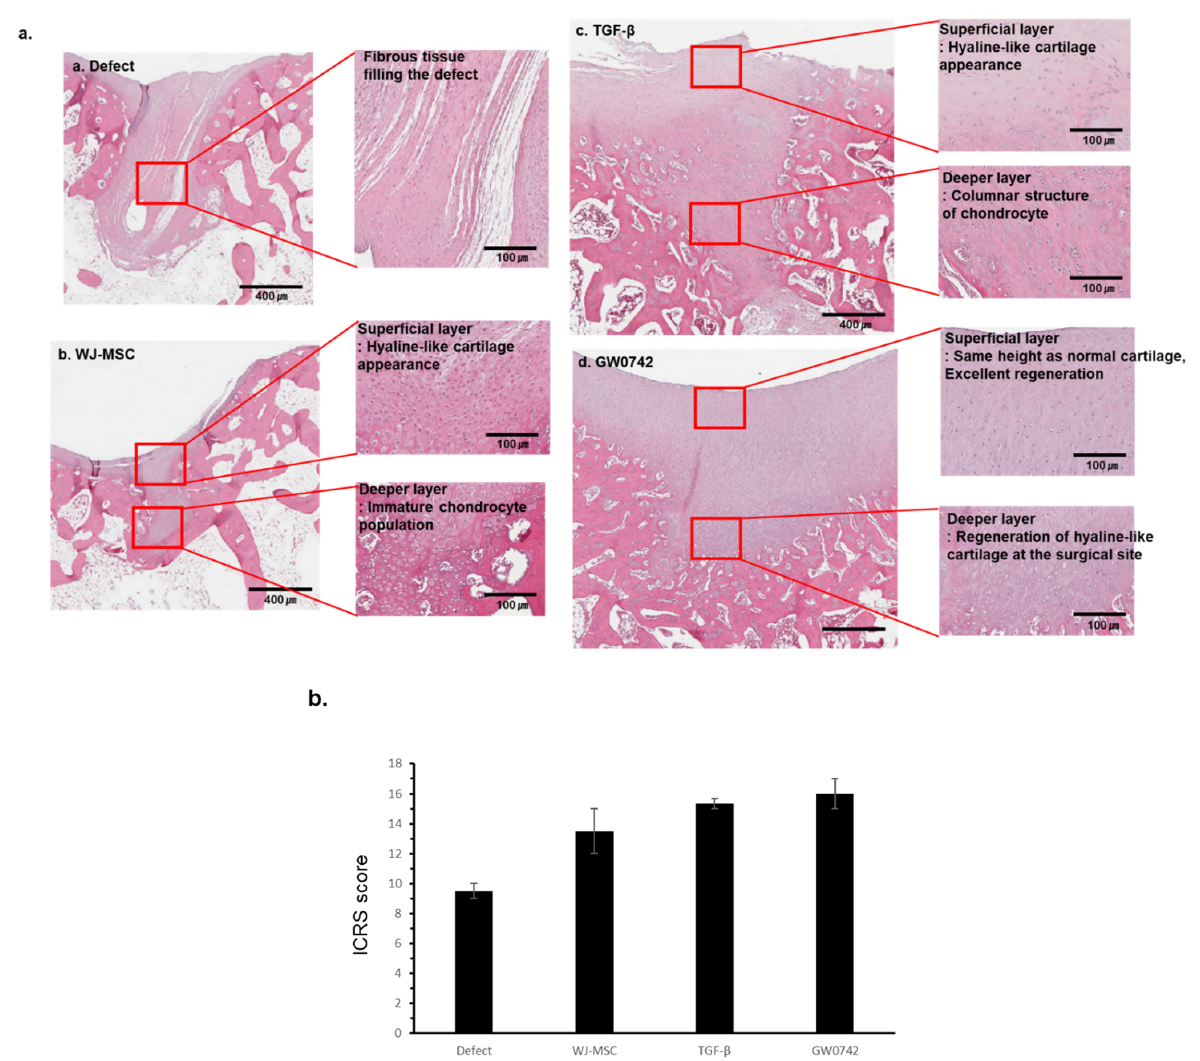
Figure 4. Histological analysis of repaired cartilage by bio-printed scaffold. Representative image of repaired cartilage at 12 weeks. ( a ) Histological observation of cartilage repair of a representative sample in each group at 12 weeks after implantation (a. defect, b. WJ-MSCs, c. TGF- β , d. GW0742; H&E staining); scale bar: 400 µm and 100 µm for each. ( b ) Histological evaluation of cartilage recovery using the ICRS Visual Histological Assessment Scale and group comparisons at 12 weeks. Data are represented as means ±